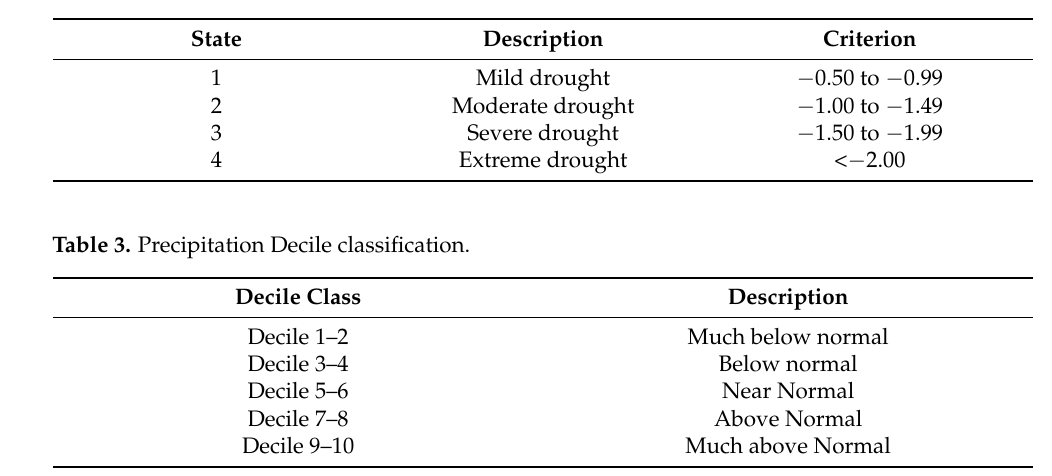
Table 2. Basic criterion for droughts.